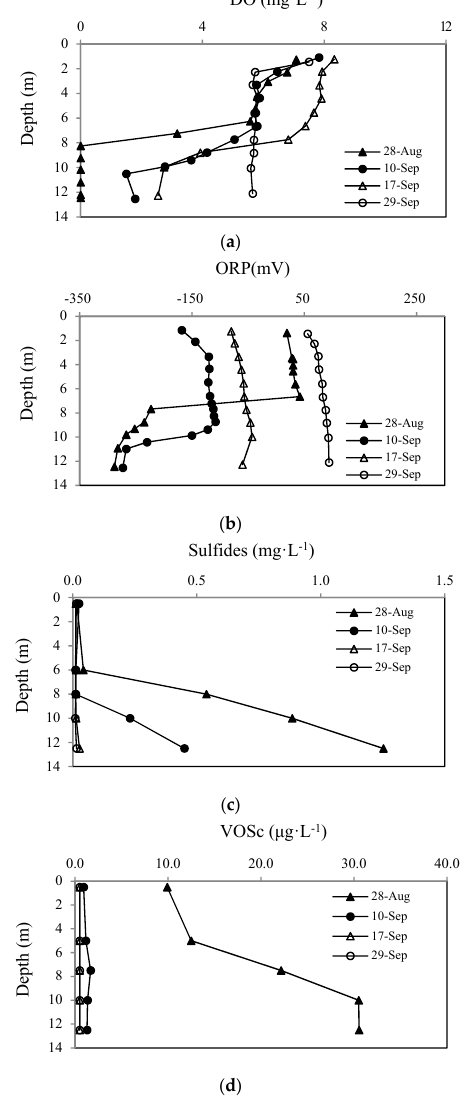
Figure 8. Vertical distributions of DO ( a ); ORP ( b ); sulfides ( c ); and VOSc ( d ) at 50 m from the Water-lifting Aerator.